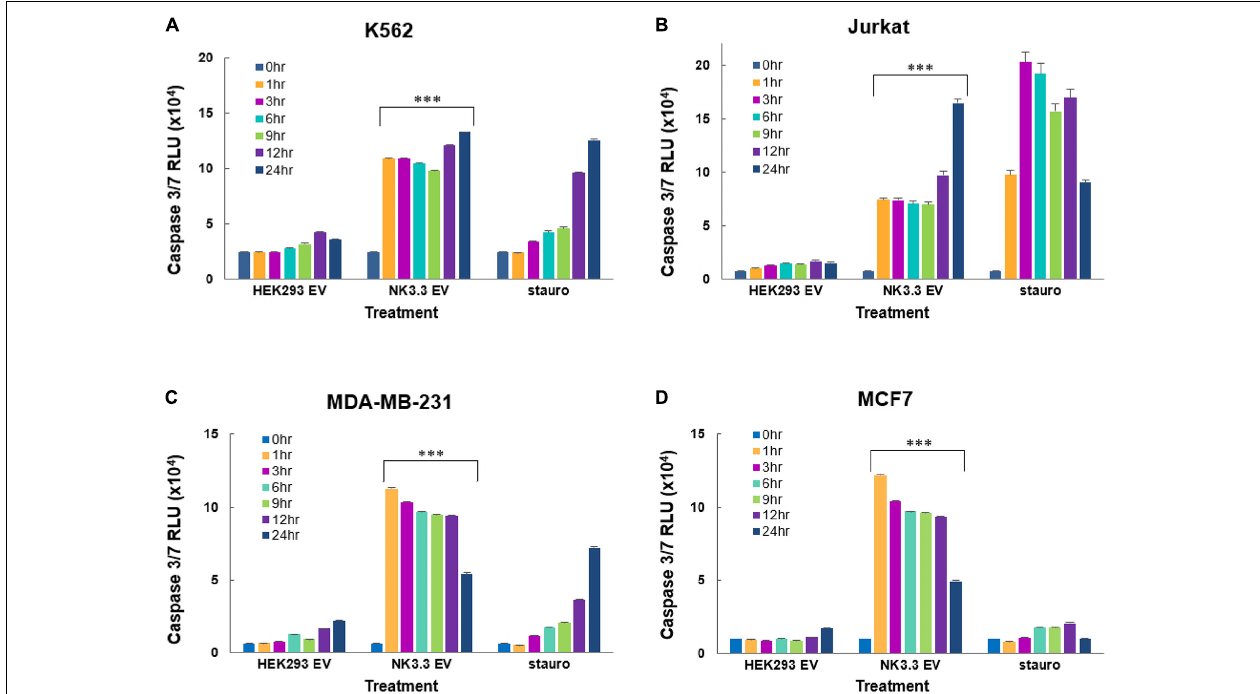
FIGURE 7 | Induction of early caspase-3/7 activity in cancer cells treated with NK3.3-derived EVs. Leukemia cells and breast cancer cells were treated with either 100 µ g/ml HEK293 or NK3.3 EVs or 2.5 µ M staurosporine. A DEVD pro-luciferin substrate was added to (A) K562, (B) Jurkat, (C) MDA-MB-231, and (D) MCF7 cells at the indicated times. A luminescent signal is generated upon cleavage by activated caspases -3 and -7. RLU: relative luminescence unit. Mean luminescence ± SE; n = 6. p- Values determined by comparison of NK3.3 EV-treated cells to HEK293 EV-treated cells. ∗∗∗ p ≤ 0.0005.